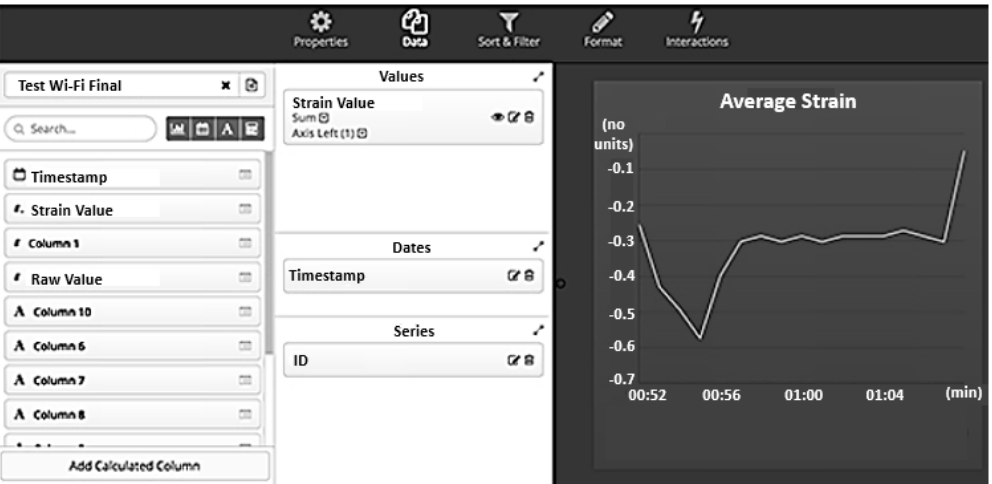
Figure 20. Graph settings for the implemented dashboard. Figure modified from [39].